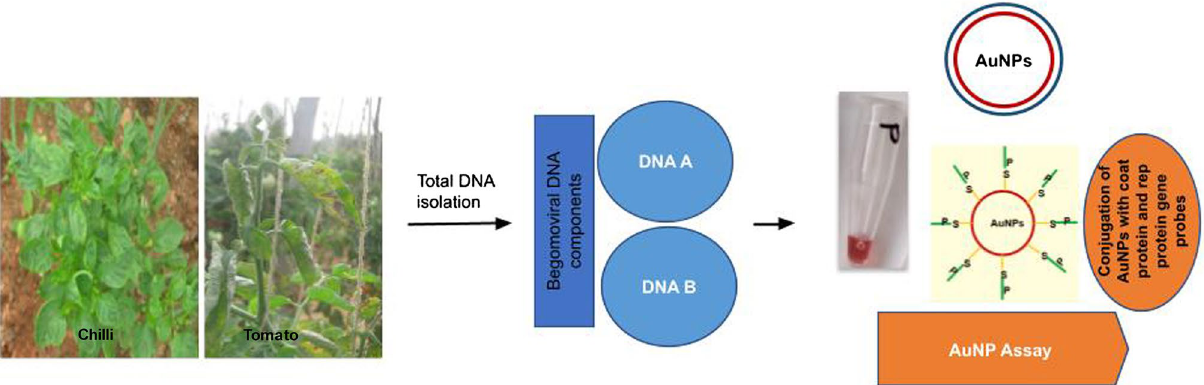
Figure 1. Schematic representation of the AuNP assay proposed in this work. Total DNA would be isolated from plant samples and screened for the presence of begomoviruses using the functionalized